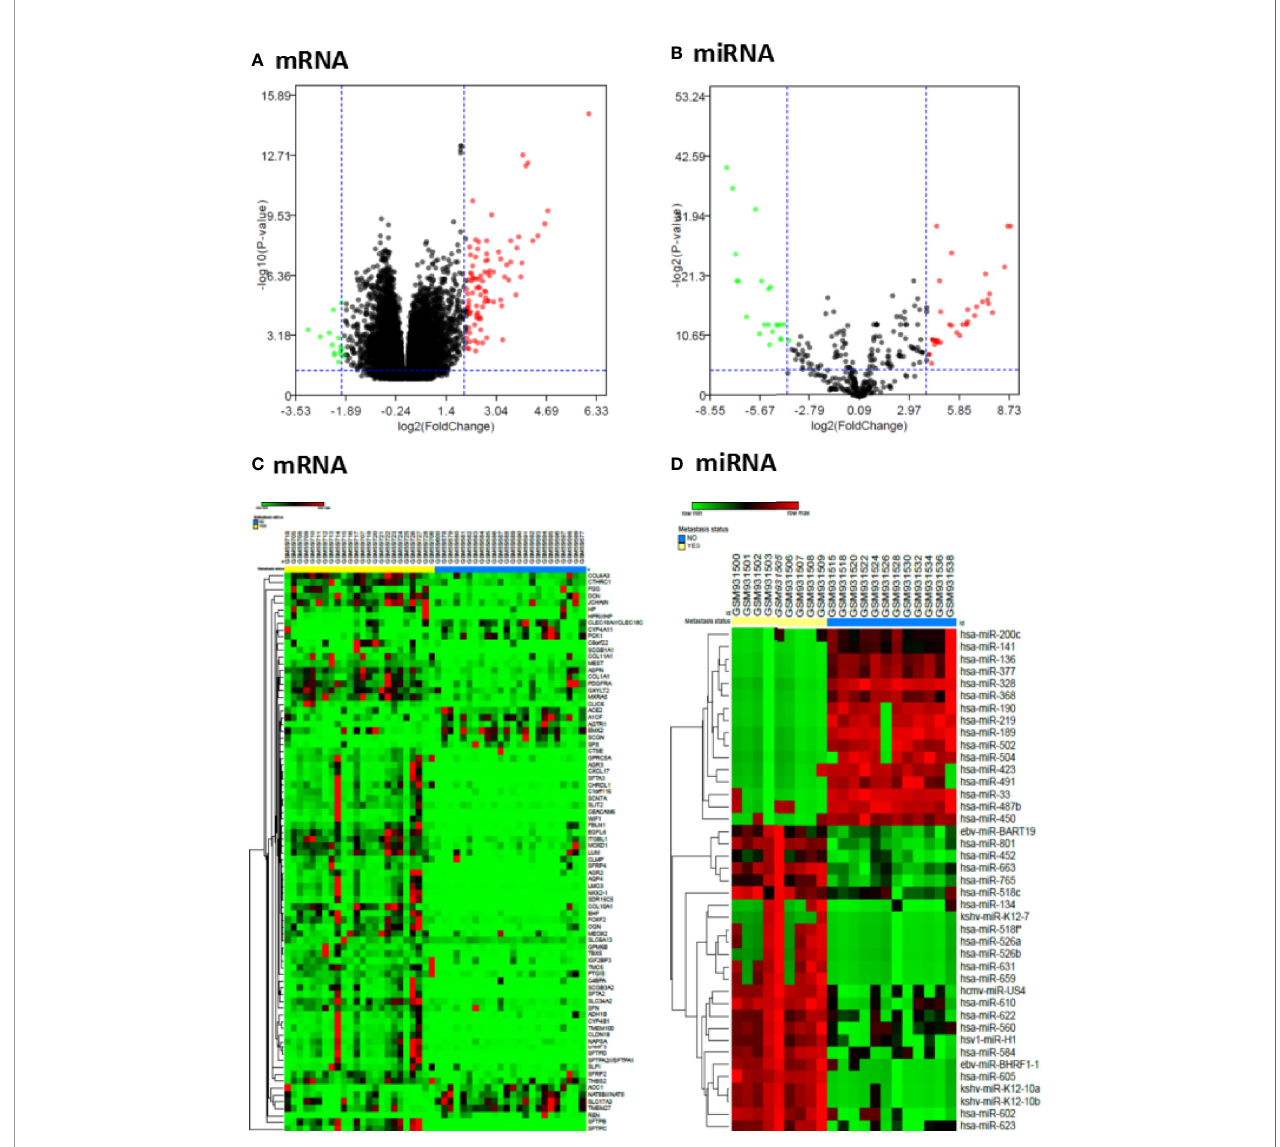
FIGURE 1 | Differentially expressed genes and miRNAs in metastatic ccRCC and primary ccRCC tissues. (A) Volcano plot of differentially expressed mRNAs from GSE22541 dataset; (B) Volcano plot of differentially expressed miRNAs from GSE37989 dataset; (C) Heatmap of differentially expressed mRNAs from GSE22541 dataset; (D) Heatmap of differentially expressed miRNAs from GSE37989